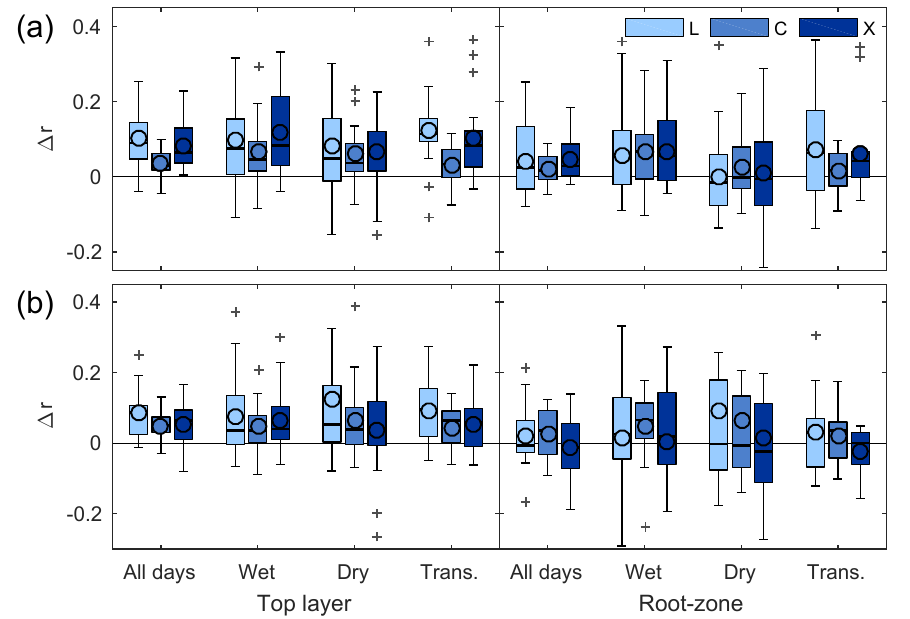
Figure 4. The change in correlation ( (cid:49)r ) between modeled and field-measured top-layer ( N = 24) and root-zone ( N = 19) soil moisture (July 2012 to April 2015) after soil moisture assimilation, where (cid:49)r is calculated over the entire time period, the wet season, the dry season, and transitional periods (a) . In (b) , the same is shown for anomaly time series. Box plots are defined as in Fig.